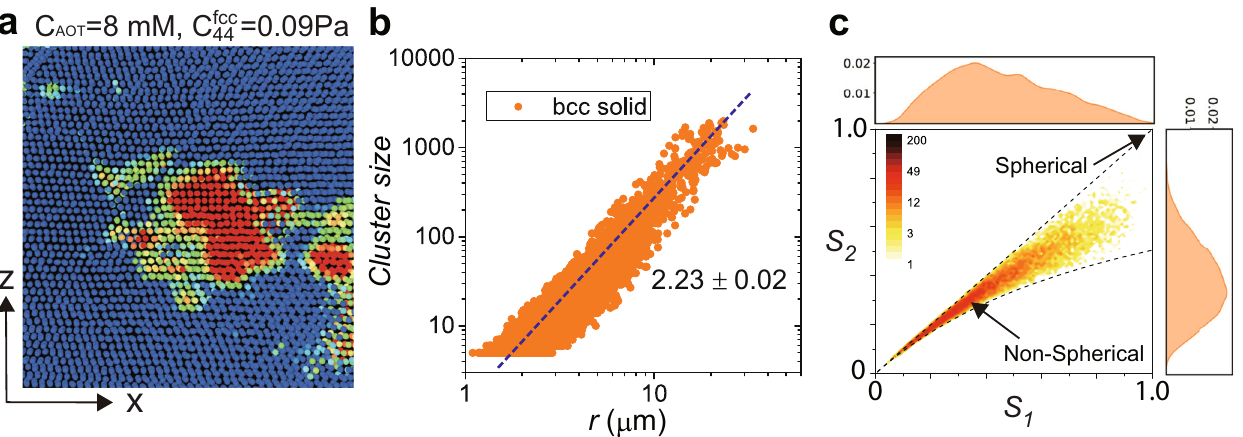
Fig. 7 Anisotropic shape and rami fi ed interface of in-grain nucleated bcc nuclei. a The x – z slice of in-grain nucleated bcc nuclei, where we can see the anisotropic shape with the rami fi ed interface, similar to the one in the x – y slice (Fig. 6a). b The distribution of the mass-gyration radius in 3D for in-grain nucleated bcc nuclei. The fractal dimension of d ~ 2.23 manifests the rami fi ed feature of the interface. c Density plot of bcc nuclei clusters on the shape- factor space ( S 1 , S 2 ), directly indicating their non-spherical shape. The point S 1 = S 2 = 1 represents a perfectly spherical shape. We can see that most bcc clusters belong to the non-spherical region. The most probable position is around (0.35,